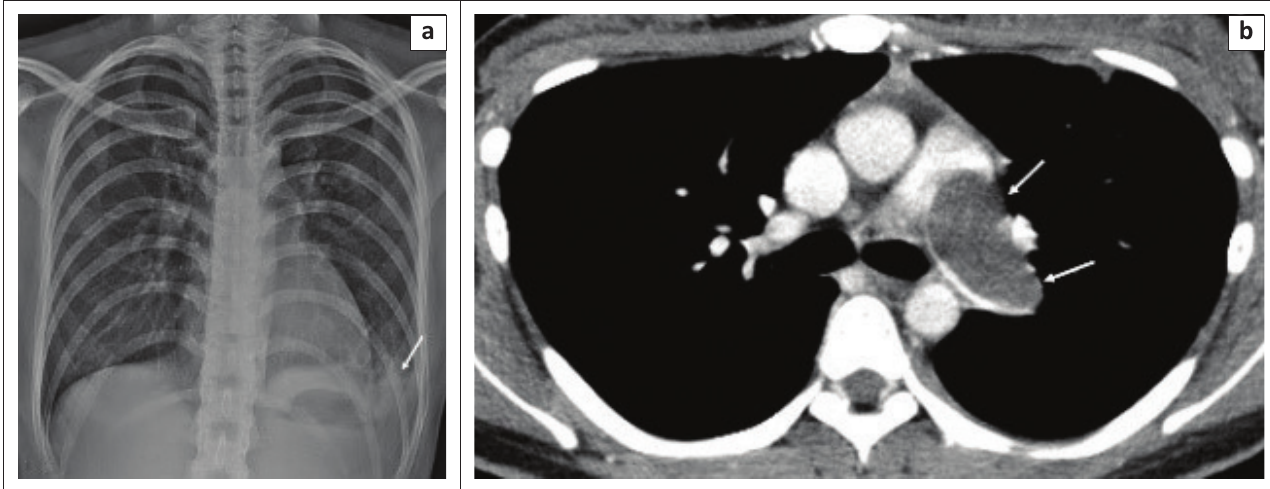
FIGURE 1: (a) Frontal chest radiograph demonstrates normal sized main, right and left pulmonary arteries with a small left basal pleural effusion (arrow). (b) Axial computed tomography pulmonary angiography demonstrated a filling defect extending from a dilated main pulmonary artery into the left pulmonary artery (arrows).